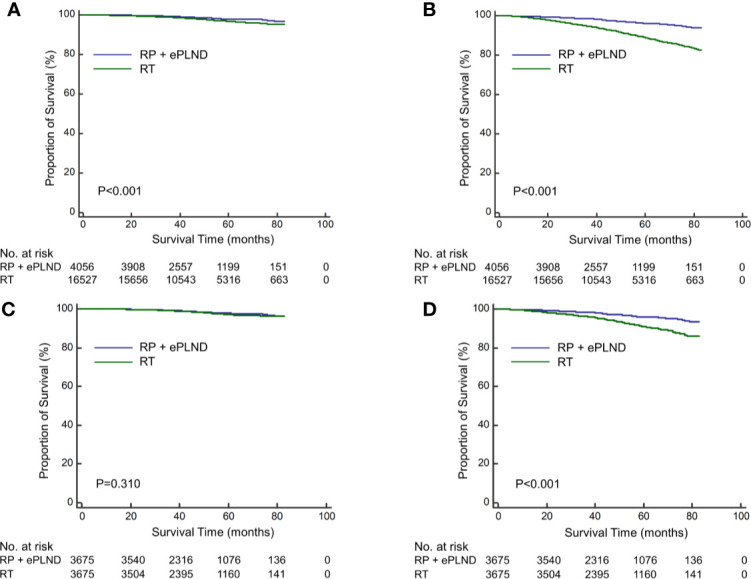
Kaplan-Meier curves of cancer-specific survival (A) and overall survival (B) for patients receiving RP + ePLND and RT in the entire cohort before PSM; Kaplan-Meier curves of cancer-specific survival (C) and overall survival (D) for patients receiving RP + ePLND and RT after PSM.